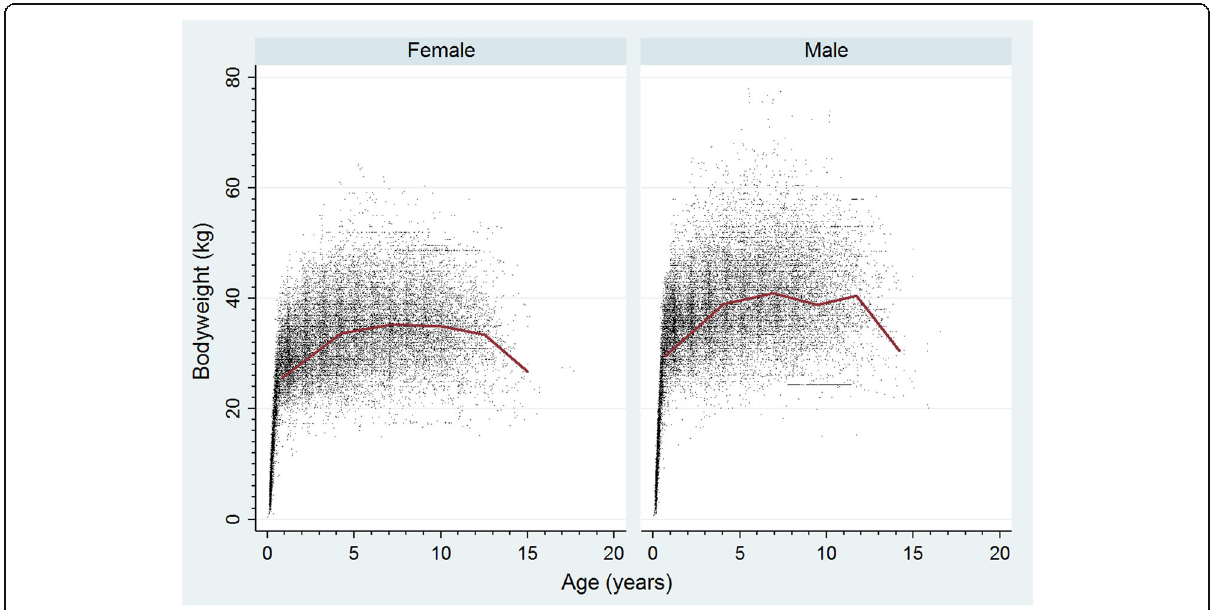
Fig. 1 Bodyweight growth curves overlaid with a cross medians line plot for female and male German Shepherd Dogs under primary veterinary care during 2013 at clinics in the UK participating in the VetCompass TM Programme. (Females n = 4073, Males n = 4104)